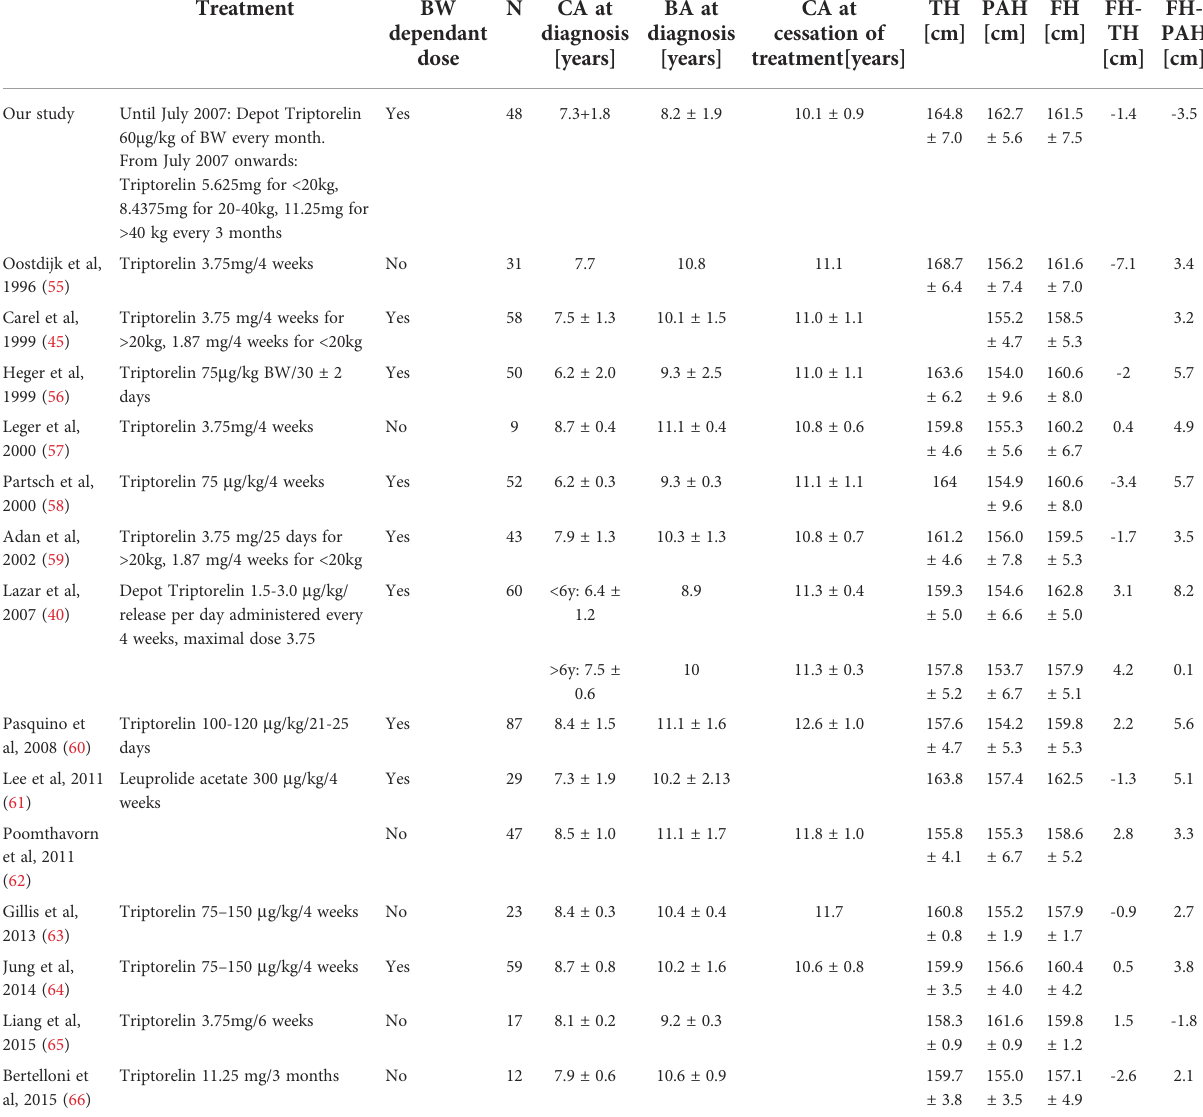
TABLE 8 Comparison of height outcomes in girls treated with GnRHa from different studies. Treatment BW dependant